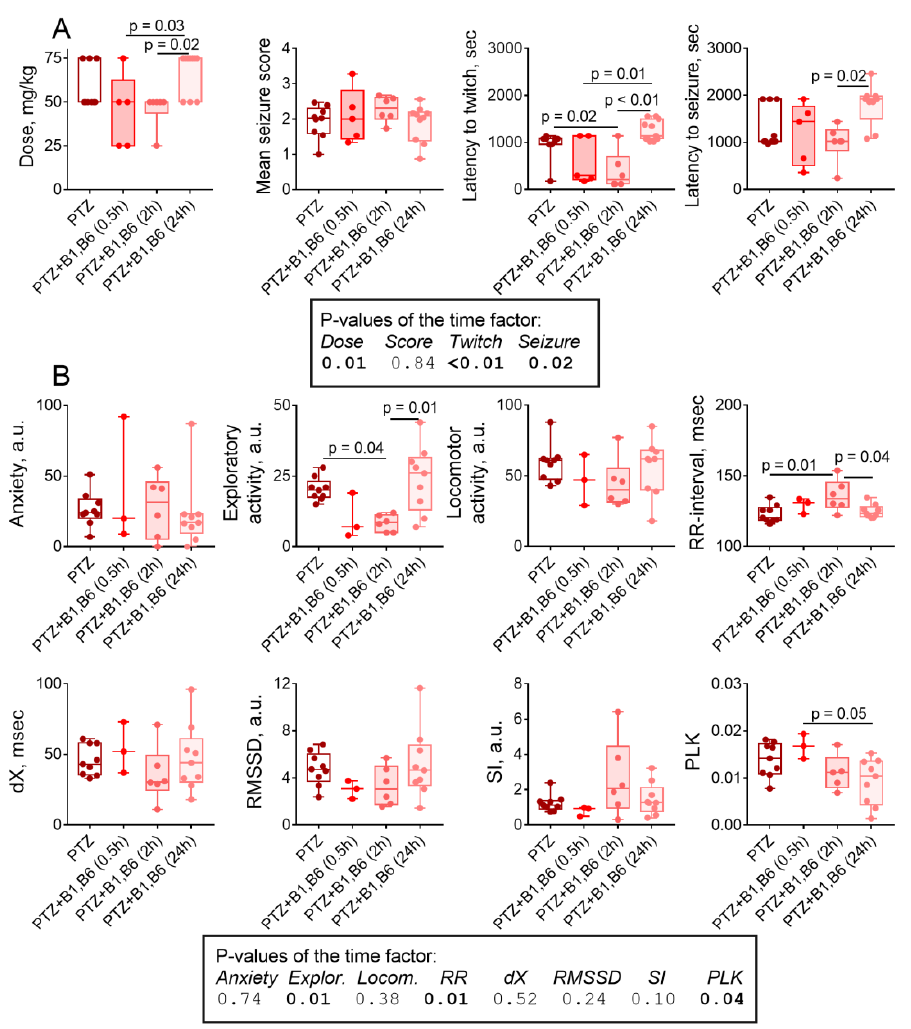
Figure 10. Dependence of pathophysiological parameters of the PTZ-induced seizure ( A ) and its delayed physiological and biochemical effects ( B ) in female rats on the interval between the administration of vitamins B1/B6 and PTZ. The assayed parameters are indicated on the Y axes and described in “Materials and methods”. The activity of the female brain PLK (micromole/min per g of tissue) is used as an indicator of biochemical changes. The statistical analysis of the data was performed by the one-way ANOVA with Tukey ’ s post hoc test (see Section 4).